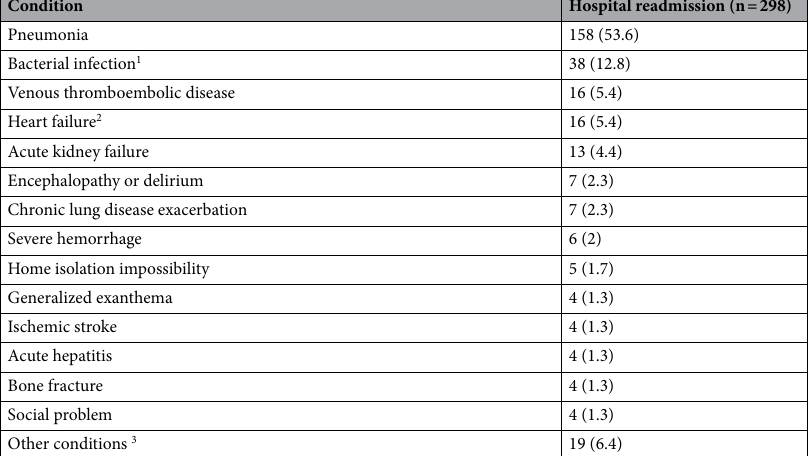
Table 5. Cause of hospital readmission in 298 patients previously admitted due to COVID-19. 1 Respiratory (18 patients), urinary tract (9 patients), intra-abdominal (6 patients), acute gastroenteritis (2 patients), Clostridioides difficile colitis (1 patient), surgical wound (1 patient). 2 Five cases due to arrhythmia and one case due to acute myocardial infarction. 3 Psychosis (3 patients), acute pancreatitis (3 patients), vasculitis (3), diabetes with hyperosmolar state (2 patient), anemia (2 patients), viral syndrome due to Cytomegalovirus (1 patient), Pneumocystis jirovecii pneumonia, Guillain-Barré polyradiculopathy (1 patient), pneumothorax (1 patient), generalized seizure (1 patient), adenocarcinoma of the pancreas (1 patient). Seven patients presented more than one cause for hospital